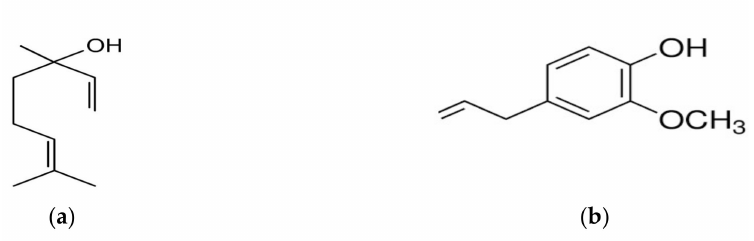
Figure 1. Chemical structures of ( a ) linalool and ( b )